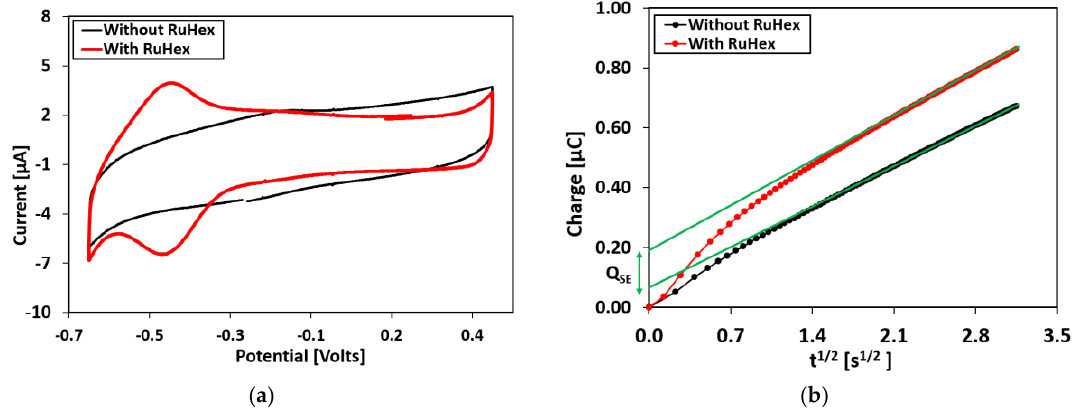
Figure A2. ( a ) Cyclic voltammograms (scan rate: 500 mV/s); and ( b ) CC responses curves of printed electrode in the presence (red) and absence (black) of RuHex.